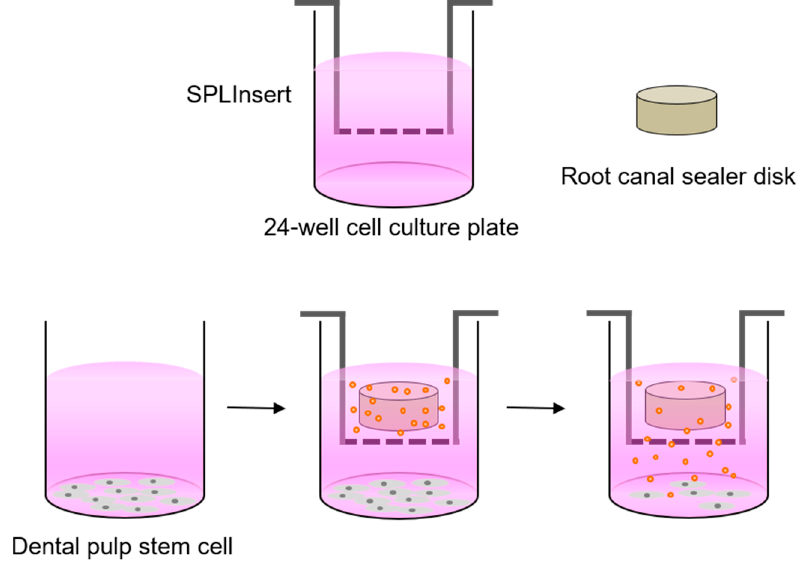
Figure 1. Experimental procedure of biocompatibility tests of each experimental sealer disk.